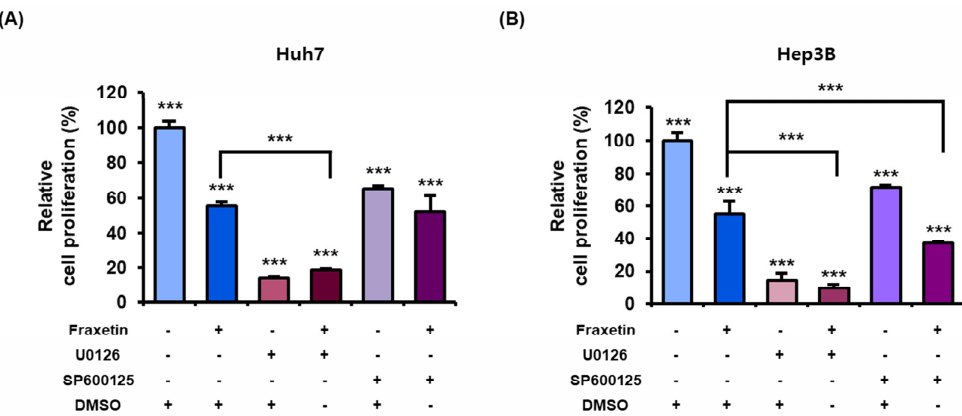
Figure 8. Synergistic effects of fraxetin with MAPK inhibitors on the proliferation of HCC cells. ( A , B ) Relative proliferation of cells treated with 20 μM of MAPK inhibitors (U0126: ERK1/2 inhibitor; SP600125: JNK MAPK inhibitor) and fraxetin (20 μM in Huh7 or 50 μM in Hep3B) for 48 h in HCC cells, then each cell proliferation was measured. Asterisks indicate the significance levels of comparisons between the control and treated groups, and fraxetin with or without MAPK inhibitors (* p < 0.05 and *** p < 0.001).